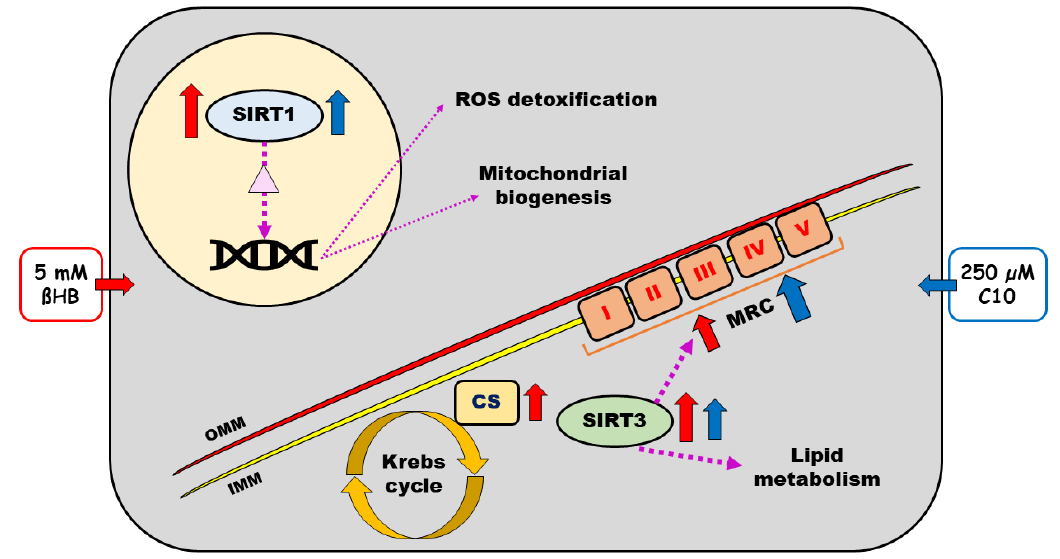
Figure 7. Schematic representation of a neuronal cell with sirtuins (Sirtuins 1–4) and respiratory chain and e ff ects of beta-hydroxybutyrate (ßHB) on the same. Purple dotted arrows represent the known regulatory e ff ects of SIRT 1–4. Solid red and blue arrows represent the e ff ects of 5 mM ßHB and 250 µ M C10, respectively. The light-yellow circle represents the nucleus with DNA and the light purple triangle therein represents transcription factors deacetylated by SIRT1 (PGC-1 α and FOXO3a). ßHB—beta hydroxybutyrate; C10—decanoic acid; CS—citrate synthase; IMM—inner mitochondrial